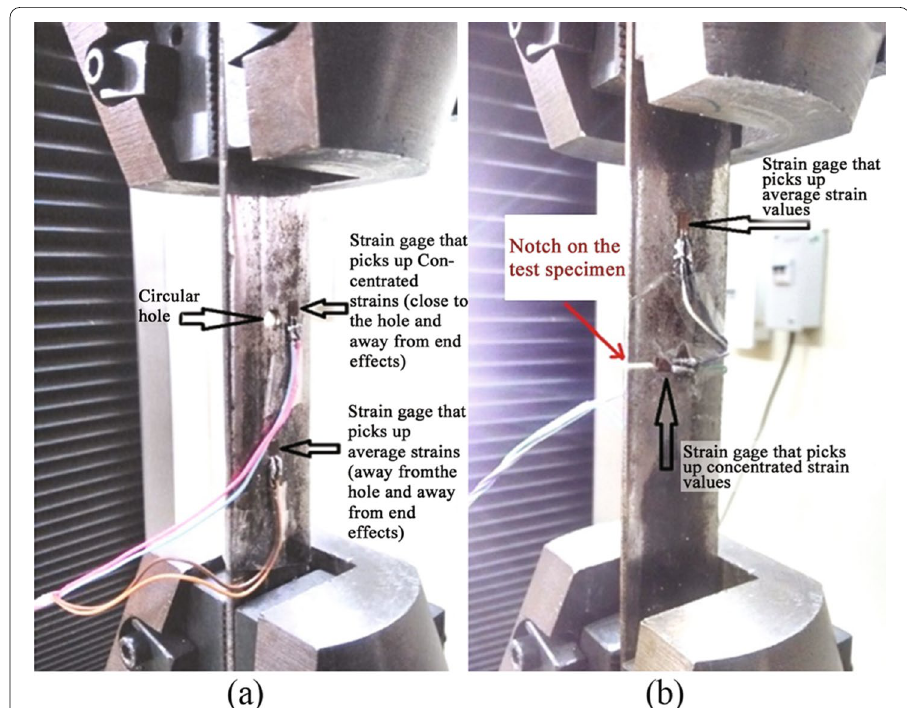
Fig. 2 Specimen loaded in the UTM for experimentation. a Specimen with circular hole and b specimen with